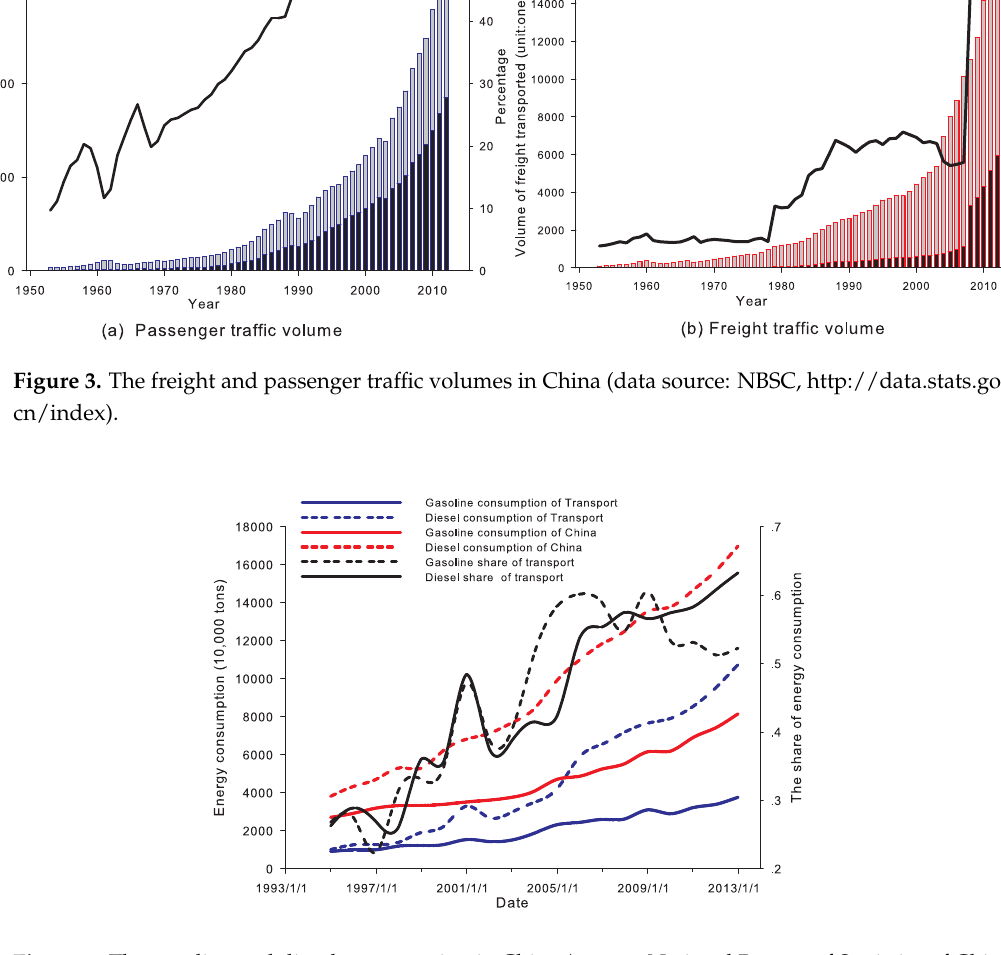
Figure 4. The gasoline and diesel consumption in China (source: National Bureau of Statistics of China (NBSC),